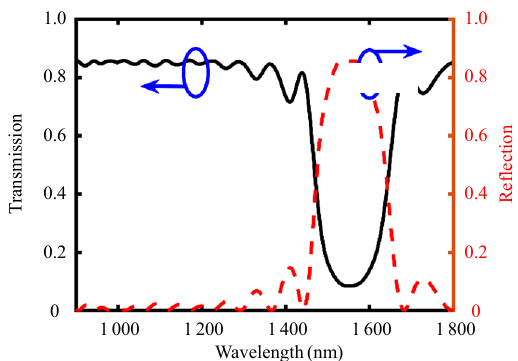
Fig. 3 Reflection spectrum (red-dash line) and transmission spectrum (black-solid line) with P = 645